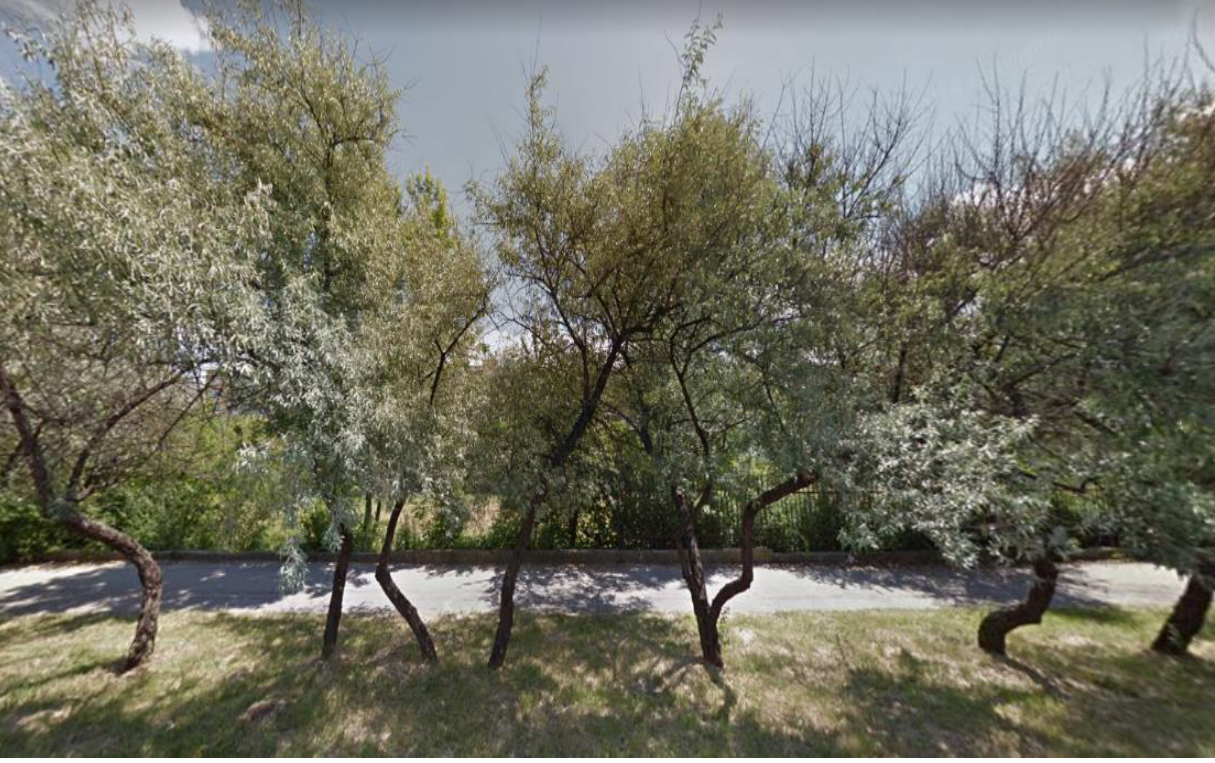
Figure 7. Tree growth anomaly (Source: Own processing, Location: Kosice, Popradska street,